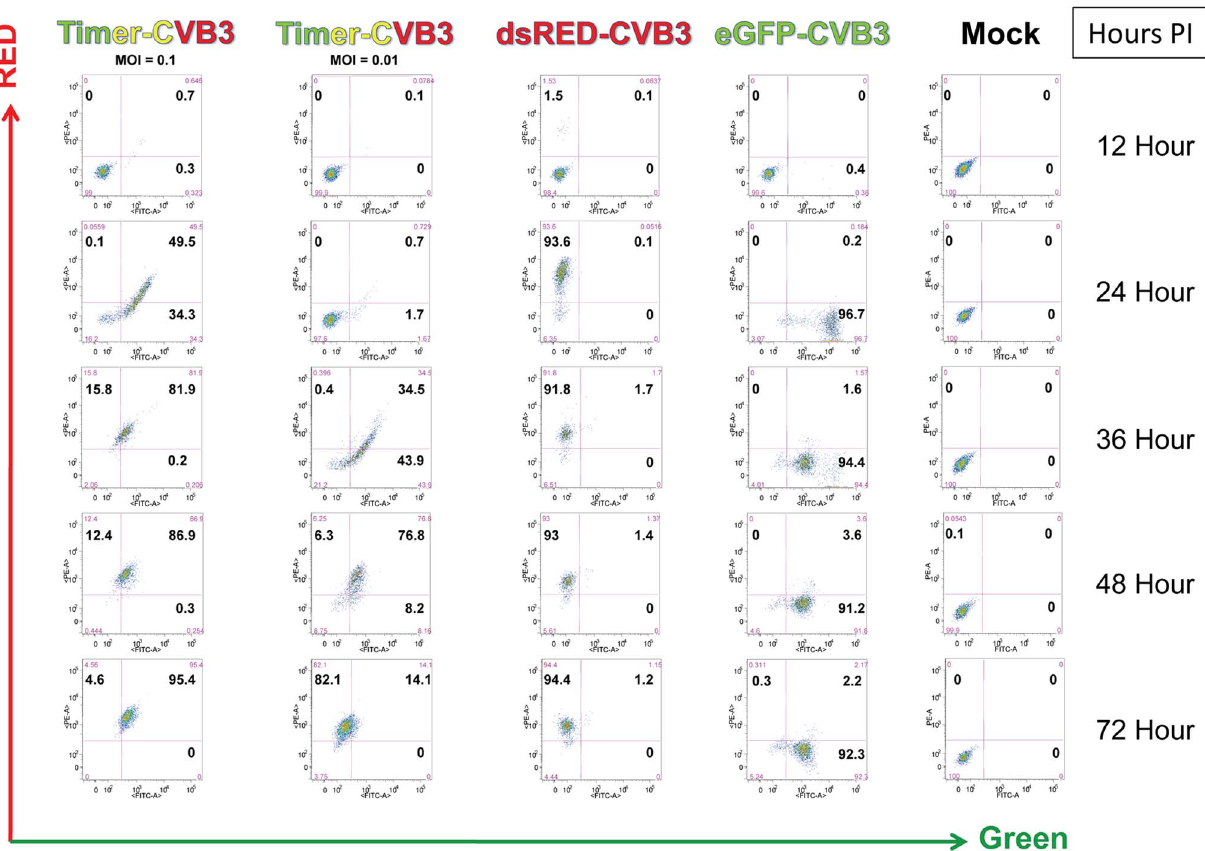
Figure 2. HeLa Cells infected with Timer-CVB3 slowly change fluorescence from green to red as determined by flow cytometric analysis. HeLa cells were either mock-infected or infected with eGFP-CVB (moi=01), dsRed-CVB3 (moi=0.1), or Timer-CVB3 (moi=0.01 or 0.1). After the indicated times post-infection, the cells were isolated, centrifuged and resuspended in a solution of 4% paraformaldehyde in 1 6 PBS for fixation overnight. The cells were then centrifuged and resuspended in 0.1% BSA/1 6 PBS, and the cell solutions were stored at 4 u C until analyzed by flow cytometry. Quadrants were set based in mock-infected control samples.